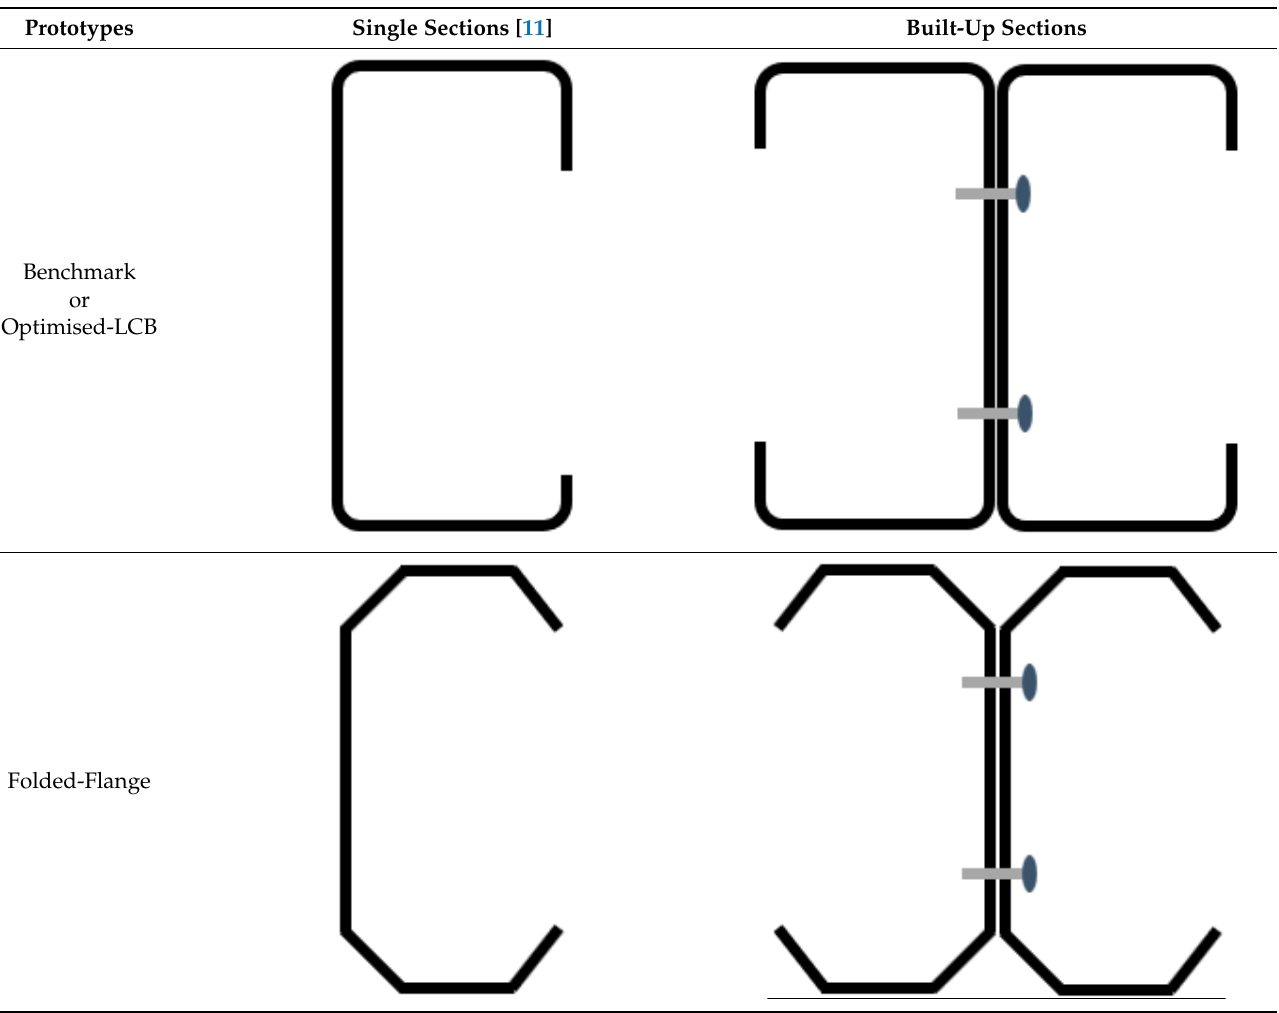
Table 1. Optimised single and built-up sections.